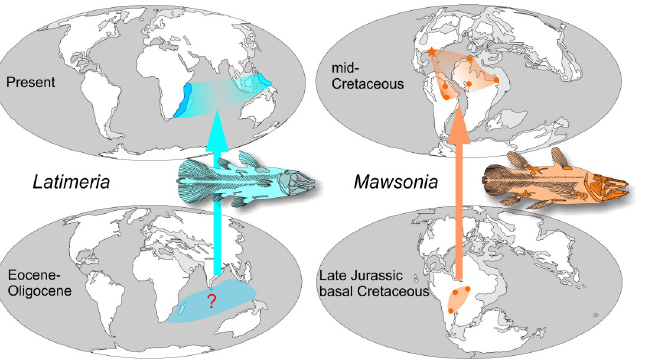
Fig 10. Comparison of the geographical distributions of the two extant Latimeria species and their supposedly common ancestor 30 to 40 million years ago (left) with those of Mawsonia in the mid-cretaceous, about 100 million years ago and in the Late Jurassic–basal Cretaceous, about 145 million years ago